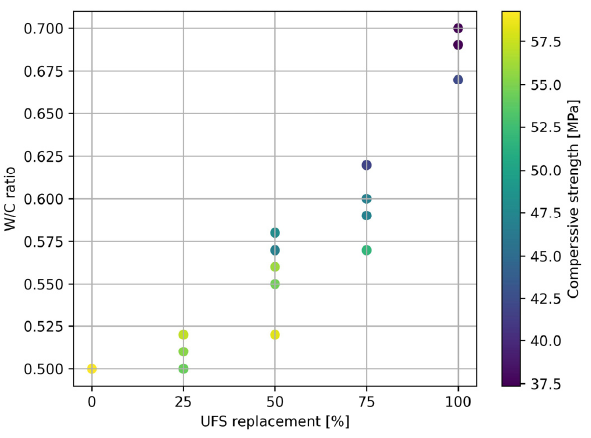
Figure 15. Compressive Strength (MPa) as function of W/C ratio and UFS replacement.